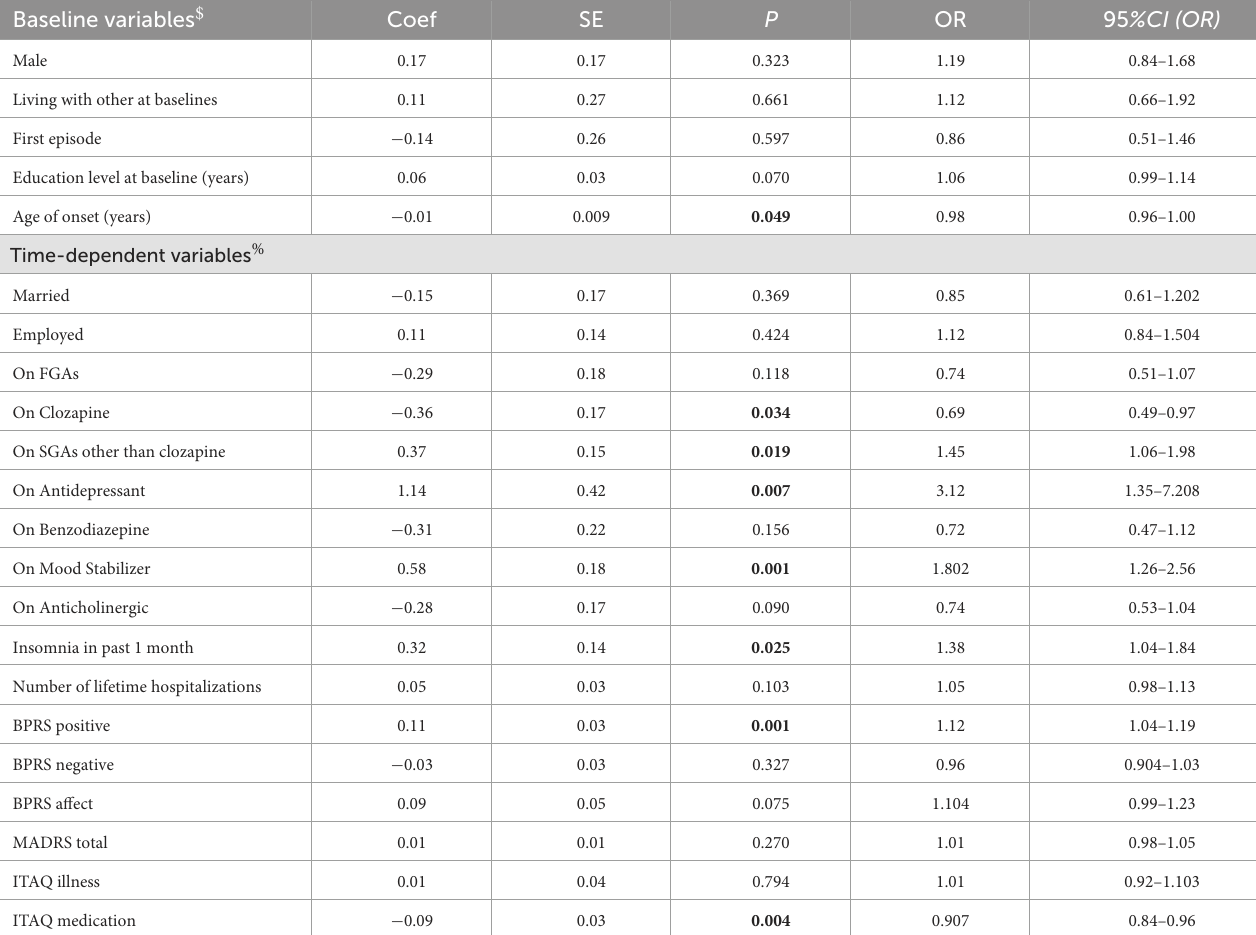
TABLE 3 Generalized Estimating Equations (GEE) results modeling risk factors associated with violent behavior in 491 patients with schizophrenia across 1